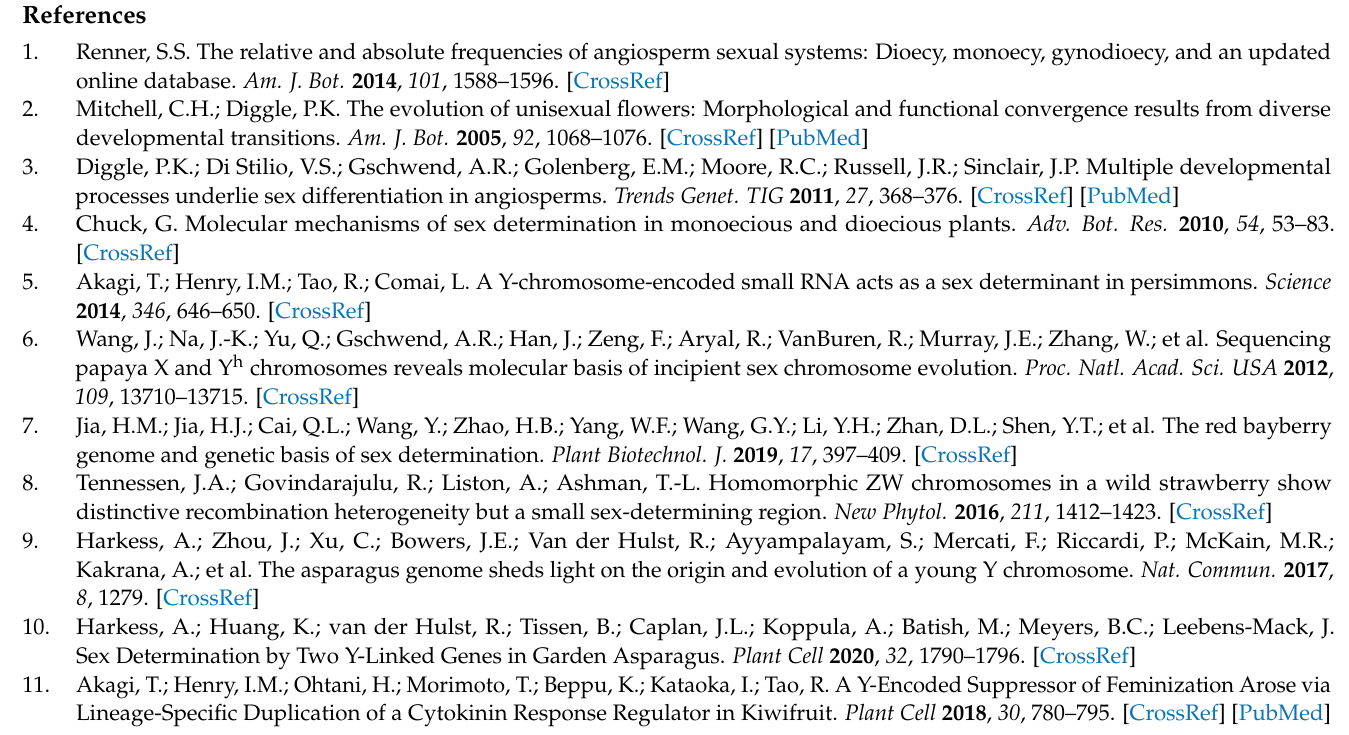
black bars represent significant differences between the samples, and values are mean ± SE (n = 3); Table S1. Raw data of sequencing sample in the study; Table S2. Level 2 gene ontology annotation of highly expressed genes in four floral buds; Table S3. KEGG enrichment analysis of highly expressed genes in four floral buds; Table S4. Level 2 gene ontology annotation of middlingly expressed genes in four floral buds; Table S5. KEGG enrichment analysis of middlingly expressed genes in four floral buds; Table S6. Level 2 gene ontology annotation of the DEGs between M0 vs. F0, M1 vs. F1, and 7029 DEGs of the two compared groups in ontologies; Table S7. List of DEGs enriched in plant hormone synthesis and the signal transduction pathway; Table S8. List of hormone-related genes identified in the 7029 DEGs; Table S9. List of hormone-related genes specifically expressed in males and females; Table S10. List of transcription factors identified in the 7029 DEGs; Table S11. List of transcription factor genes specifically expressed in males and females; Table S12. The element enriched in promoter region of hormone-related genes; Table S13. List of genes in the light-green and dark-cyan networks; Table S14. Annotation of genes in light-green module; Table S15. Annotation of genes in dark-cyan module; Table S16. List of primers used for